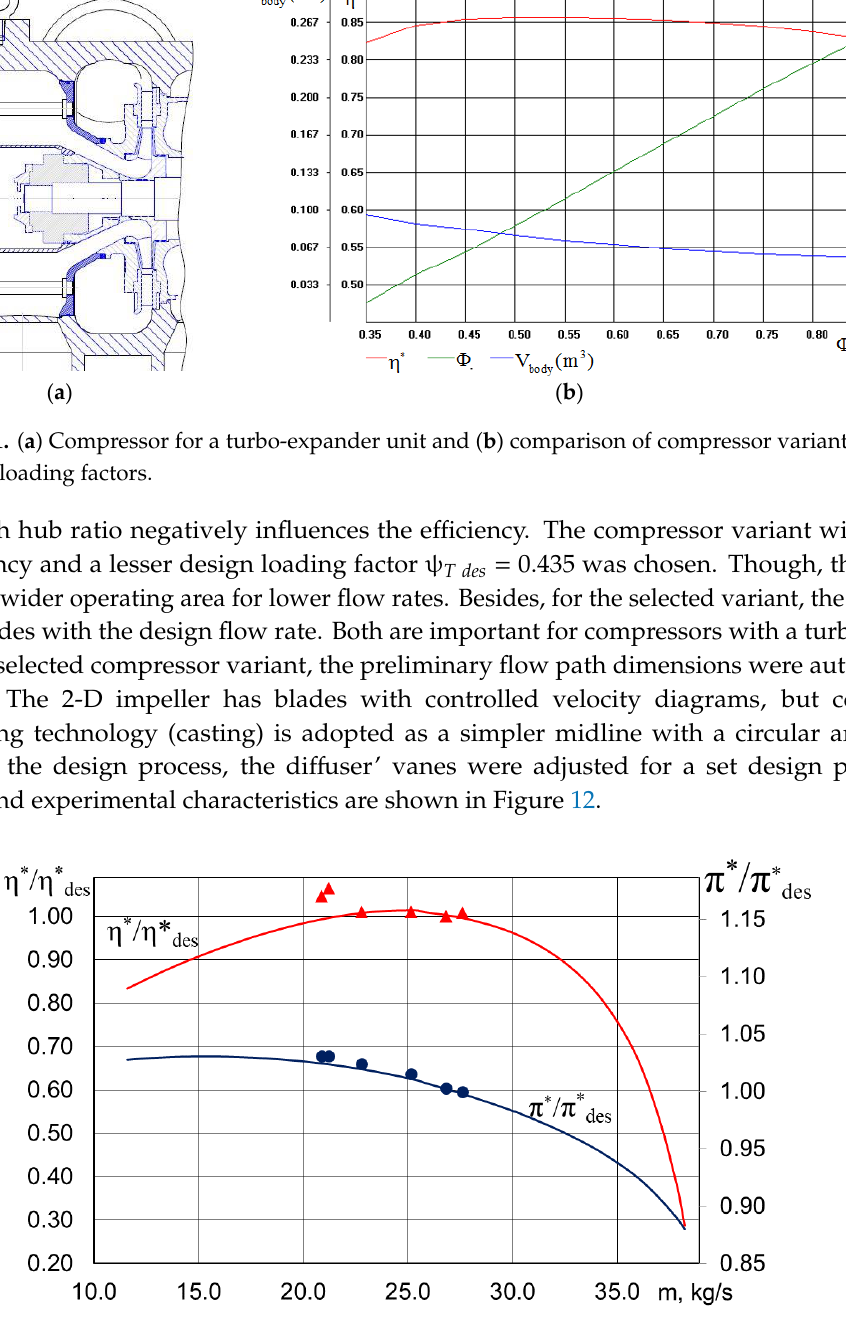
Figure 12. Design characteristics of the turbo-expander compressor and the experimental results.